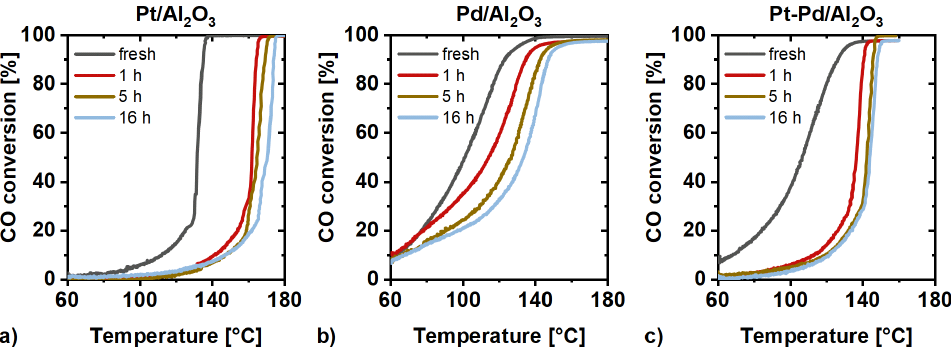
Figure A2. Catalytic activity for CO conversion after oxidative pretreatment of Pt/Al 2 O 3 ( a ), Pd/Al 2 O 3 ( b ), and Pt-Pd/Al 2 O 3 ( c ) during a light-off test in 800 ppm CO, 7% CO 2 , 5% O 2 , 5% H 2 O, and bal. N 2 at a GHSV of 80 000 h − 1 .